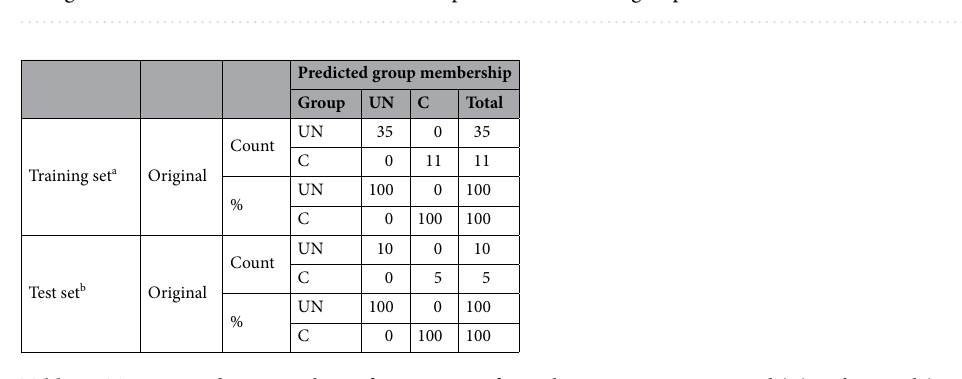
Figure 2. Diagram of scattering of scores corresponding to contaminated and uncontaminated seeds in the space of the first two Principal components. Each score corresponds to one seed. The left side shows the histograms of the scores of the second main component of these two groups.